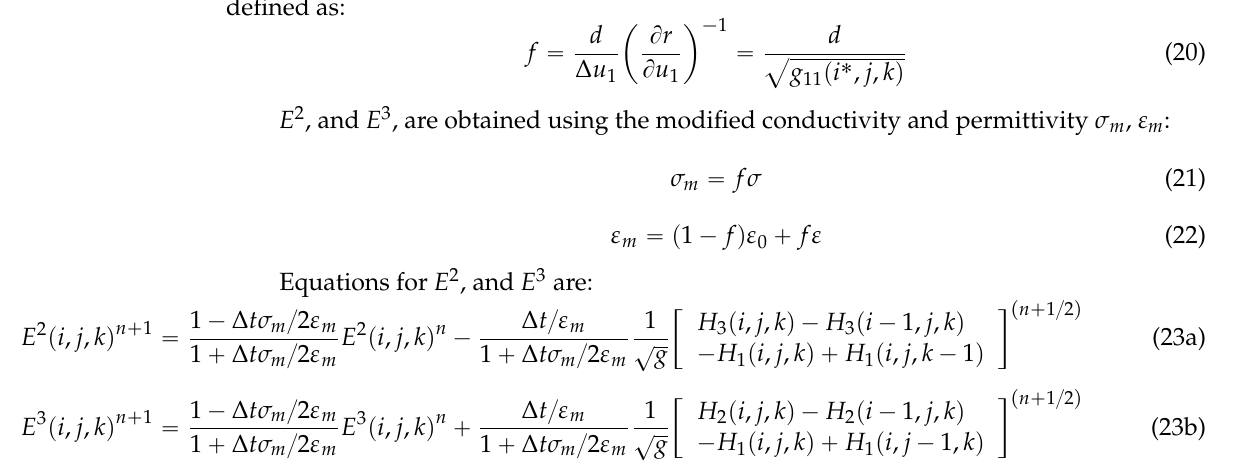
The updated equations for the electric fields tangential to the slab are obtained by considering that only a portion d of the enclosed path is inside the material, the factor f is defined as: